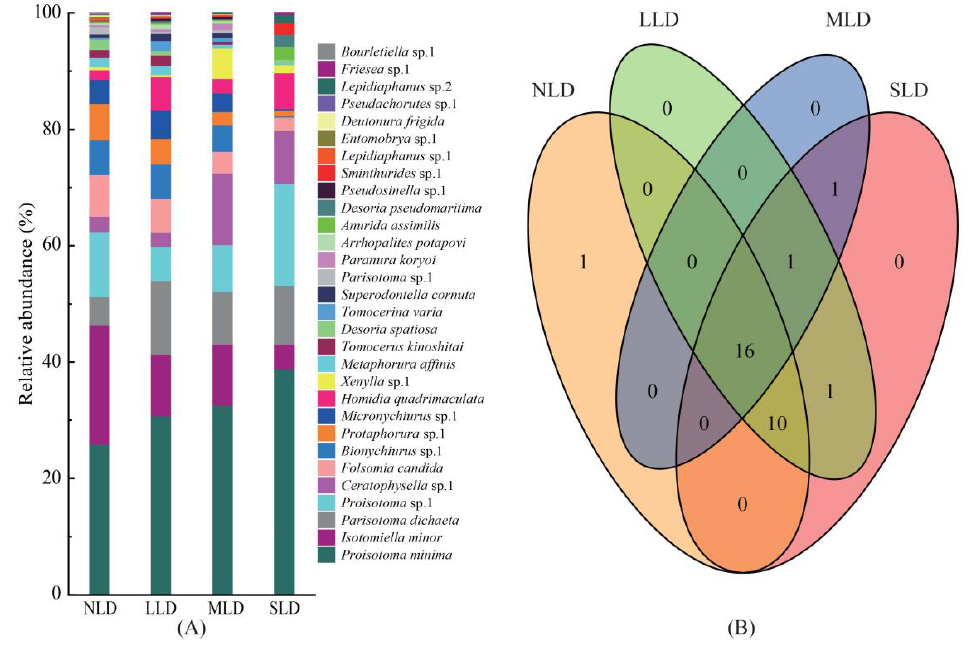
Figure 1. Characteristics of soil Collembolan communities. ( A ) The relative abundance was defined as the percentage of soil Collembolan communities in different degrees of land degradation; ( B ) Venn diagram of the number of shared and unique soil Collembolan species in different degrees of land degradation. The numbers in the circles indicate either the unique number of species in a habitat or the number of shared taxa in the overlapping regions. Soil Collembolans were counted form three seasons during the study period. NLD, no land-degradation habitat; LLD, light land-degradation habitat; MLD, moderate land-degradation habitat; SLD, severe land-degradation habitat.